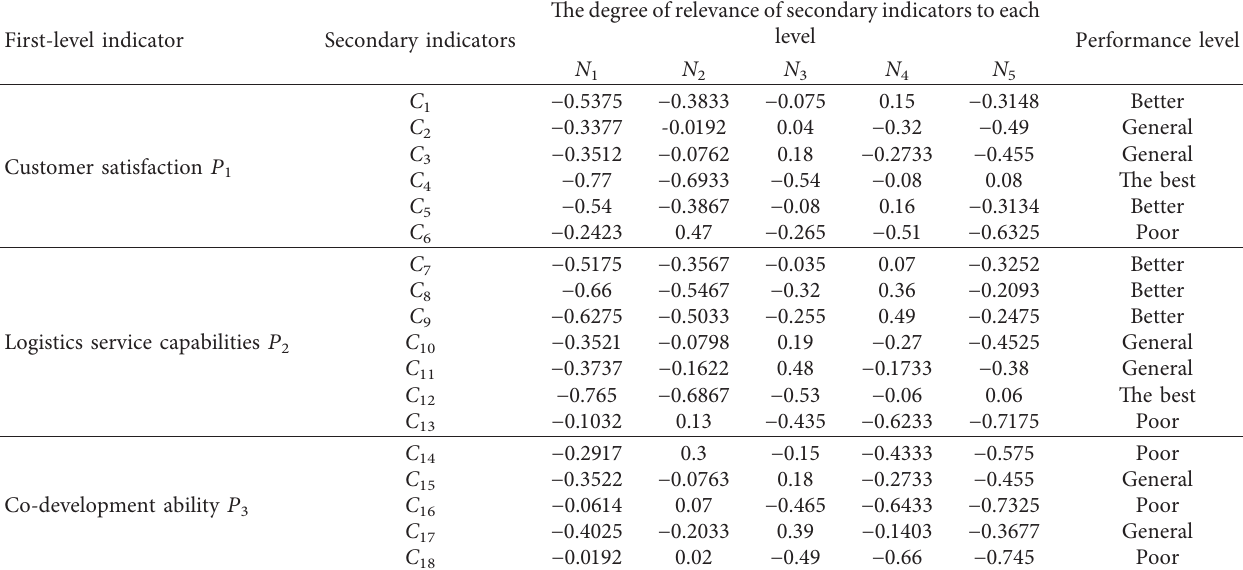
Table 4: The correlation of the five levels of the secondary indicators of the S enterprise logistics service supply chain performance evaluation